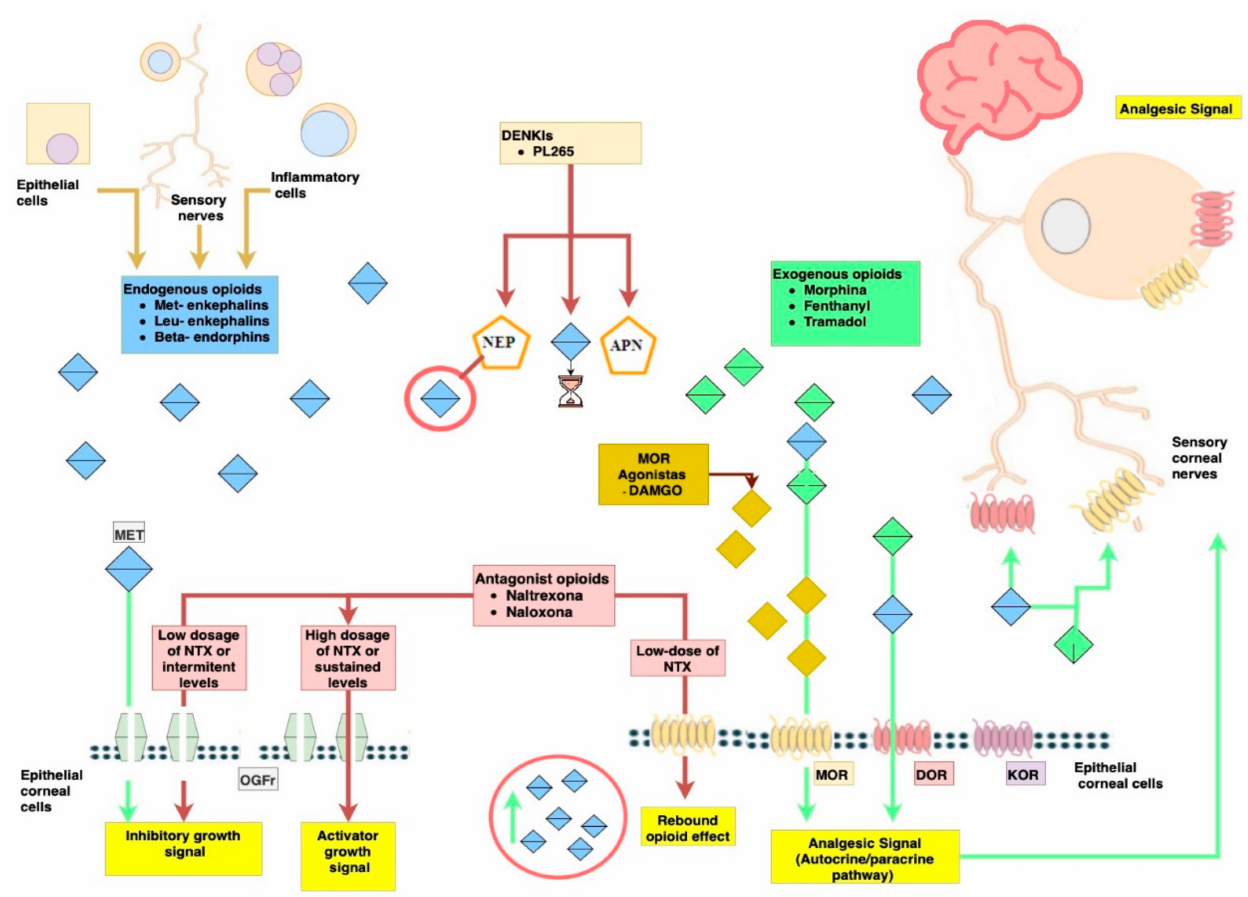
Figure 1. Endogenous opioids have different affinities from the opioid’s receptors (MORs, DORs, KORs, and OGFr) distributed by epithelial cells, endings terminal nerves, and trigeminal ganglion. In the synaptic space and in the cornea surface catabolic enzymes (NEP and APN) control the elimination and average life of endogenous opioids. There are multiples forms to control the pathway: the introduction to exogenous opioids (green rhomboids), the specific agonist of different opioids receptors, the use of antagonist of the via (Naltrexone) and his different dosage and levels, and the use of inhibitors of catabolic enzymes to achieve an increase of average life of natural